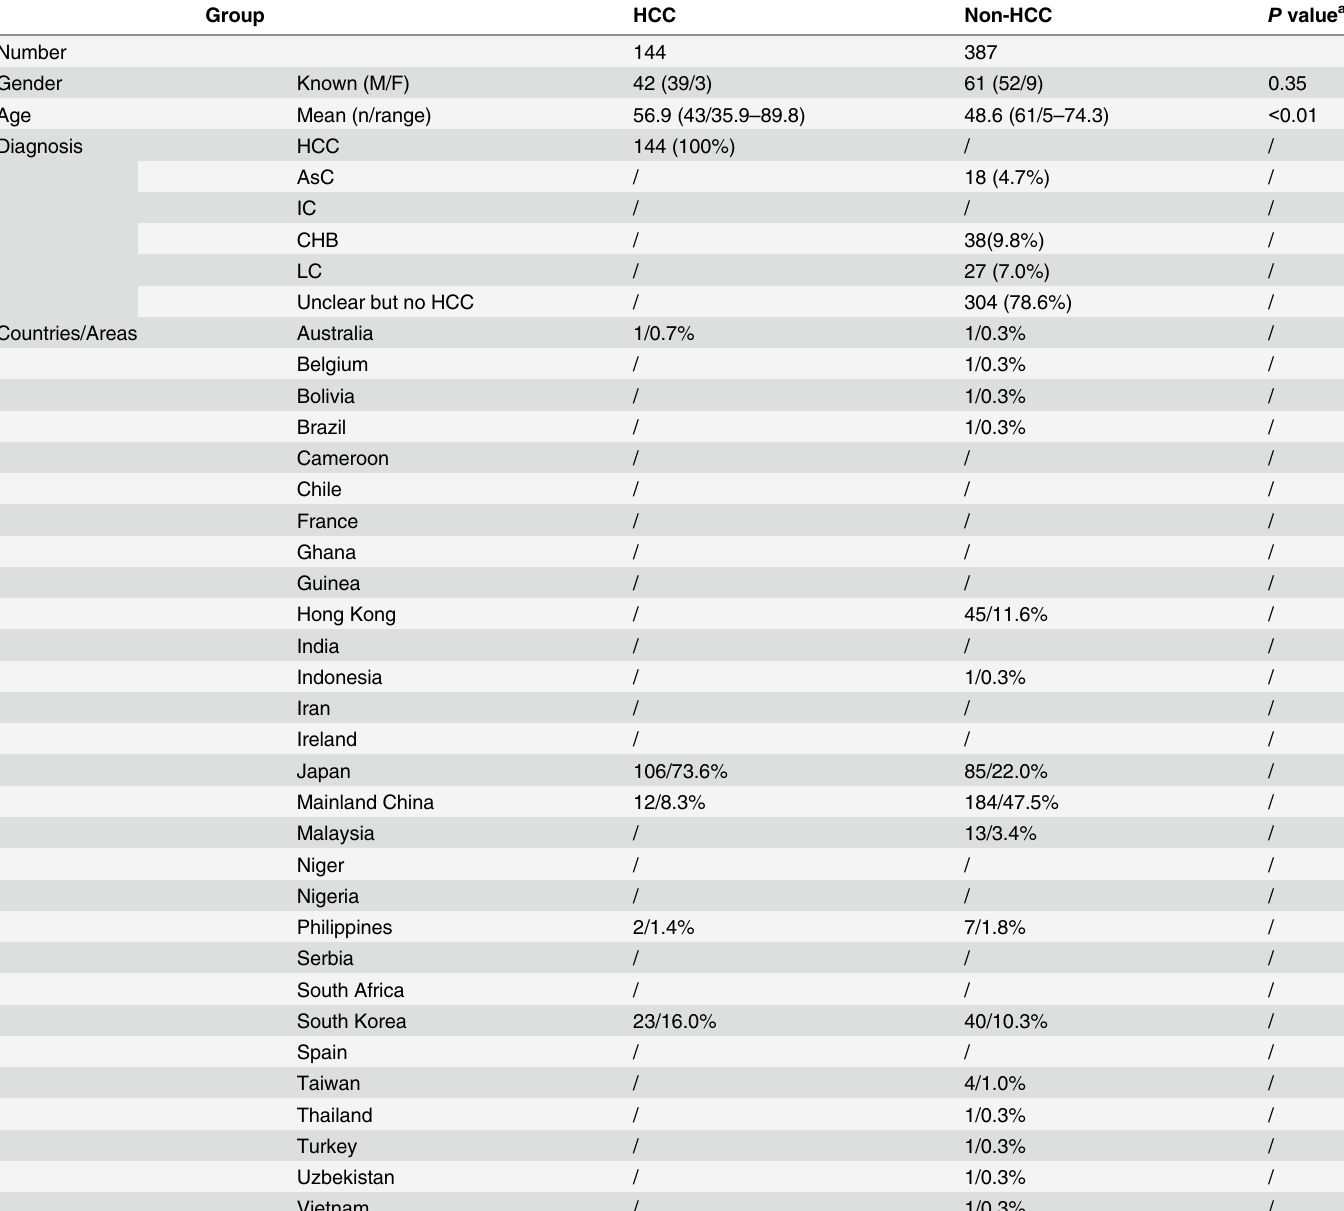
Table 2. The demographic information of enrolled genotype C